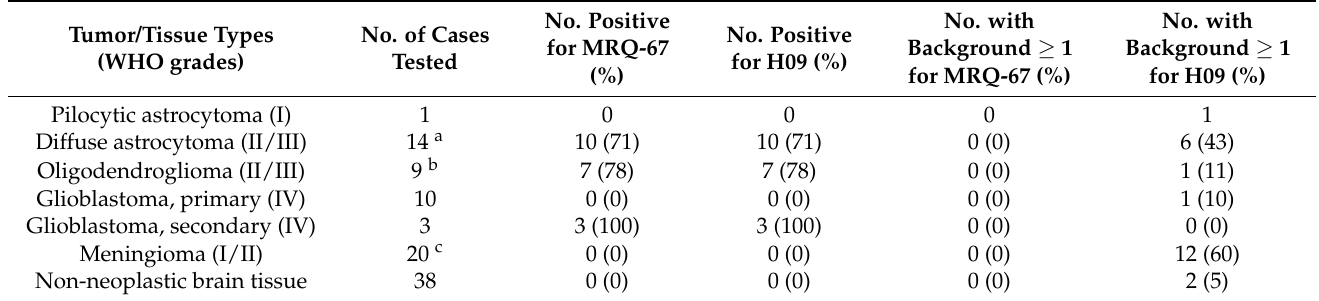
Table 4. Performance of MRQ-67 (2.54 µ g/mL) and H09 (3.25 µ g/mL) in IHC on 95 FFPE tissue samples.